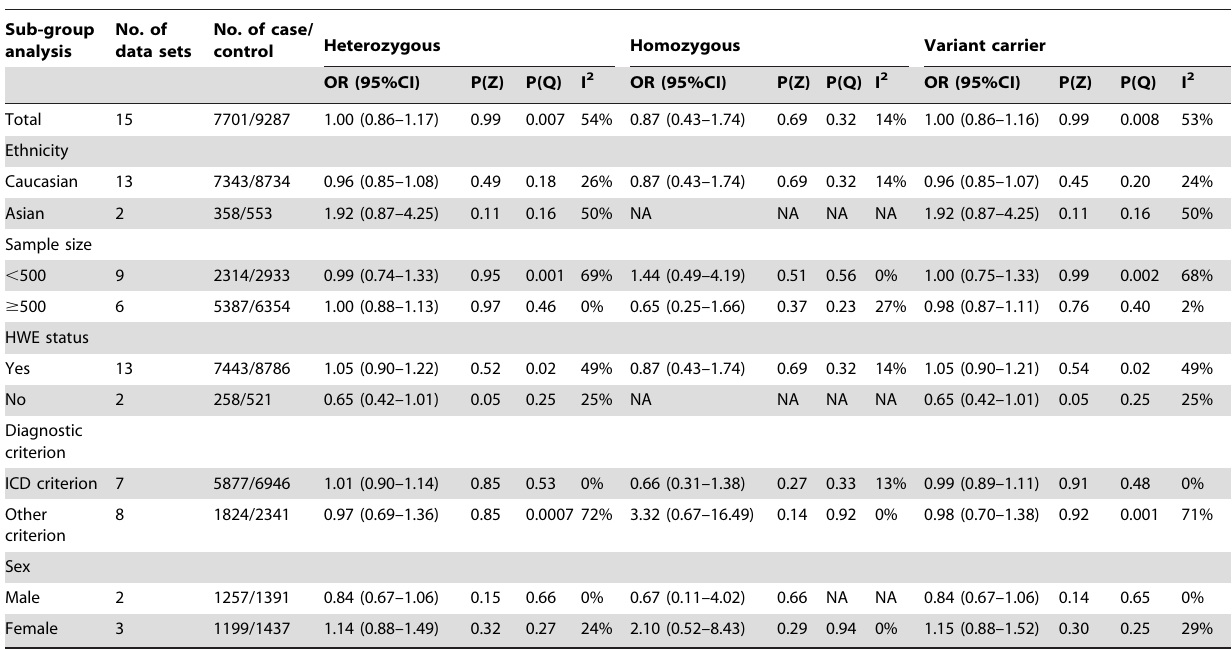
Table 3. Meta-analysis of the CYP2C9 *3 polymorphism on colorectal cancer susceptibility.